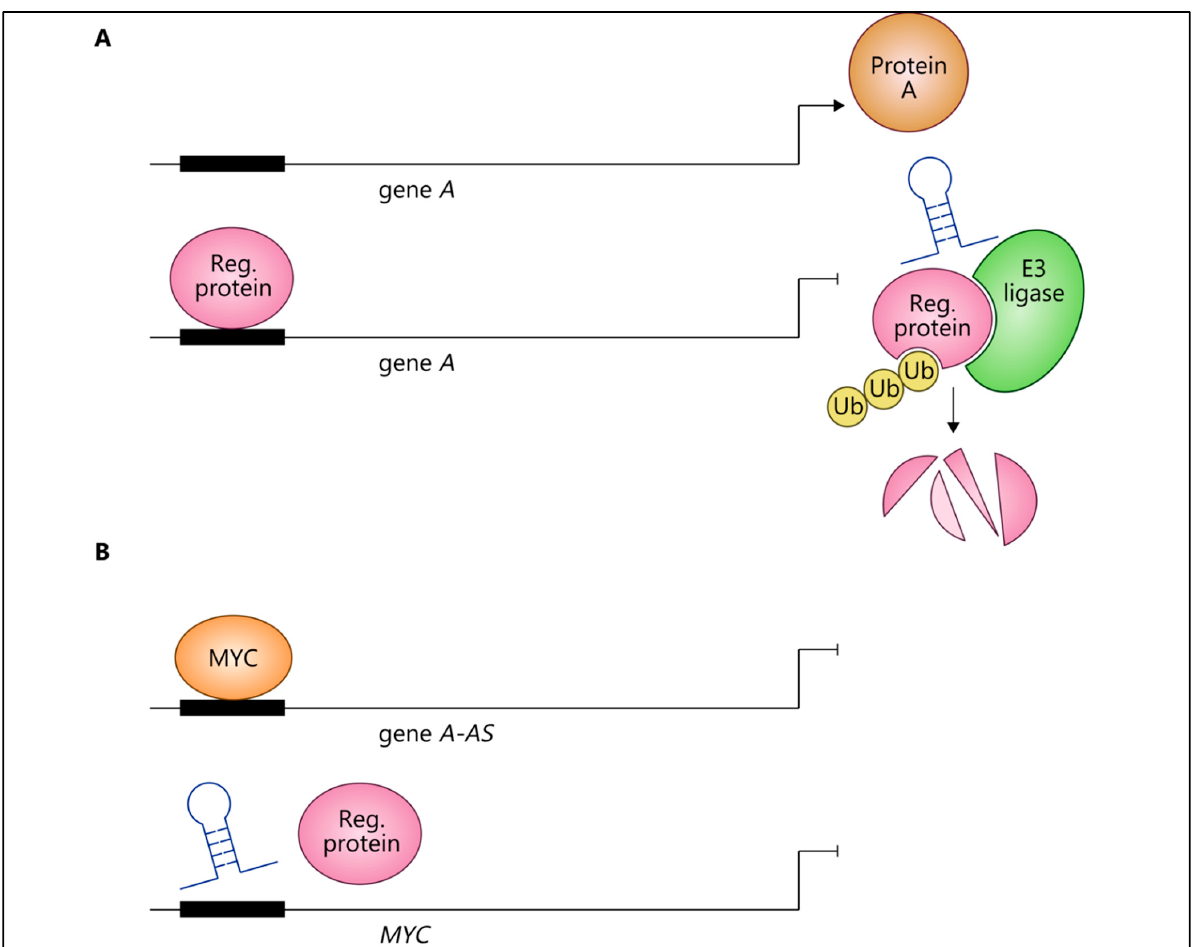
Figure 3. A negative feedback loop involving MYC, lncRNAs, and ubiquitin ligase. ( A ) LncRNA (encoded by gene A-AS1 , e.g., MTSS1-AS1 ) upregulated the expression of gene A (e.g., MTSS1 gene) acting as a scaffold between E3 ligase and a regulatory protein (e.g., MZF1), leading to ubiquitination-mediated degradation of the regulatory protein; hence, protein A (e.g., MTSS1) was produced. The regulatory protein (e.g., MZF1) inhibited gene A (e.g., MTSS1 gene) expression by binding its promoter. ( B ) MYC inhibited the lncRNA (e.g., MTSS1-AS1 ) by binding its initiator elements ( gene A-AS , e.g., MTSS1-AS1 ). In turn, the lncRNA (encoded by gene A-AS , e.g., MTSS1-AS1 ) inhibited MYC expression by impairing its regulatory protein-mediated transcriptional activation. Reg. = regulatory.